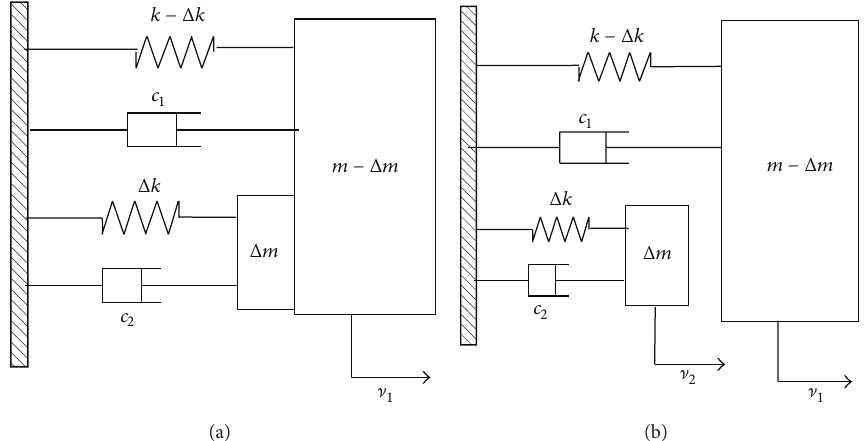
Figure 11: On-off stiffness model with viscous damping model considering a secondary spring with mass: (a) the systems are rigidly attached; (b) the secondary mass is disconnected and oscillates independently of the main mass.